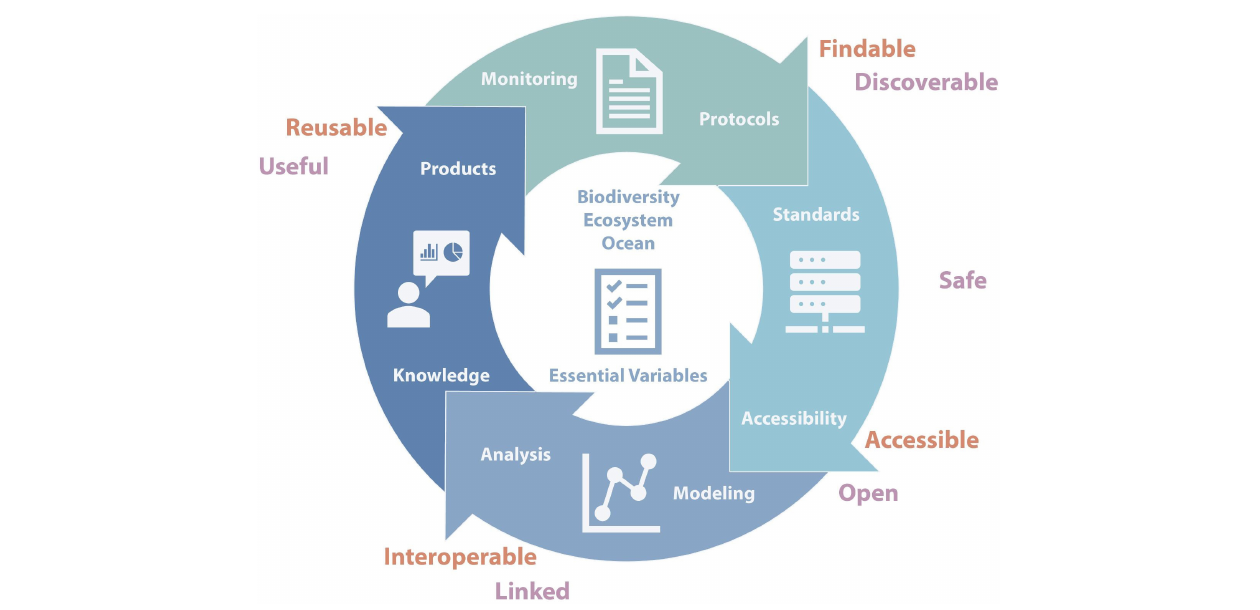
FIGURE 1 | Conceptual representation of the different components of an integrated system for the Southern Ocean centred around Essential Variables (EOVs, EBVs, and eEOVs) and linked to the FAIR Principles (red) and IPY data vision